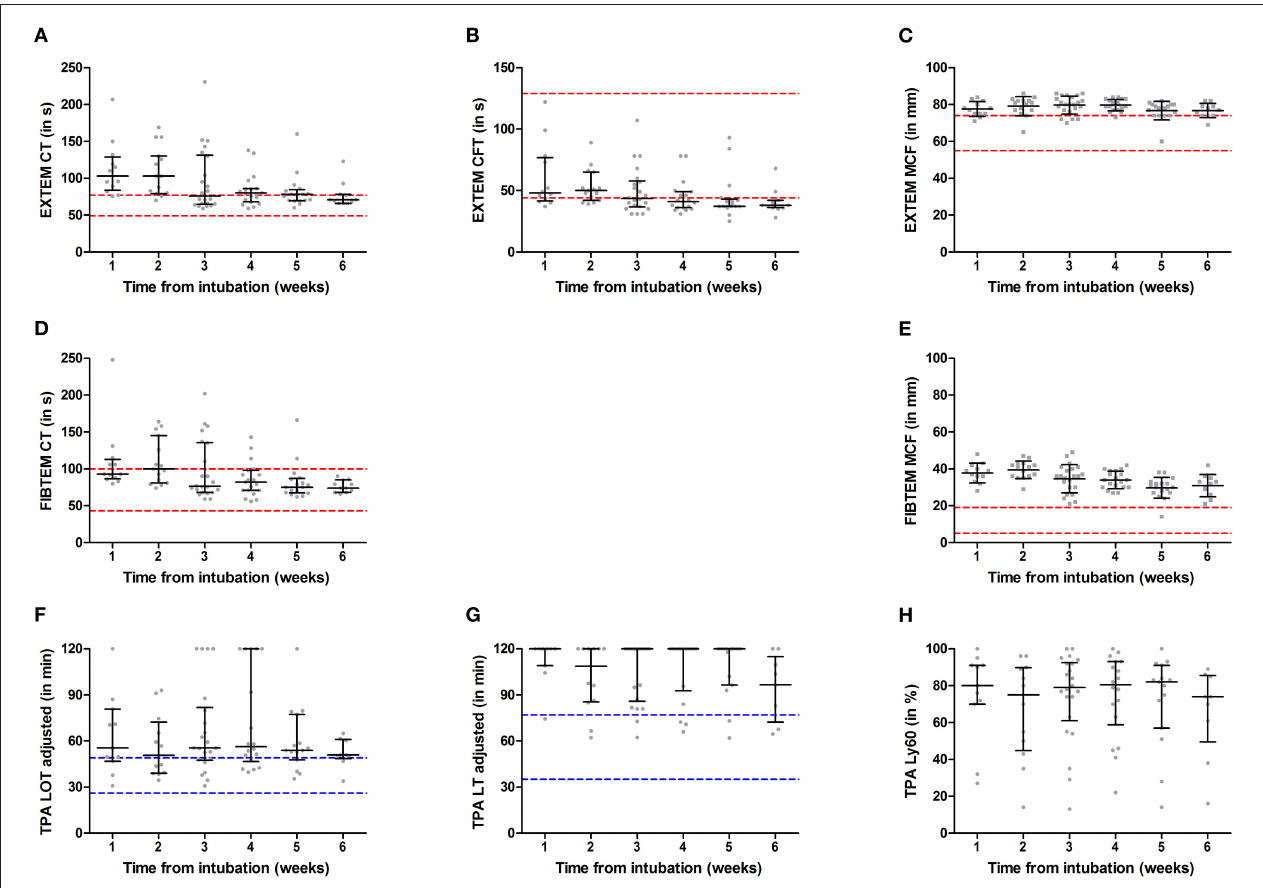
FIGURE 2 | ROTEM EXTEM (A–C) , FIBTEM (D,E) , and tissue plasminogen activator (TPA) (F–H) measurements over 6 weeks from intubation in a critically ill COVID-19 population. Results are presented as mean with standard deviation ( (cid:4) ) or median with interquartile range ( • ); gray symbols illustrate individual measurements. Red dashed lines represent MUMC + ROTEM reference ranges and blue dashed lines represent tPA ROTEM reference ranges as determined by Kuiper et al. ( 20). CT, clotting time; CFT, clot formation time; MCF, maximum clot firmness; LY60, lysis index at 60min; LOT, lysis onset time; LT, lysis time. TABLE 4 | Number (percentage) of prolonged EXTEM clotting time (CT) and prothrombin time (PT) measurements. Week